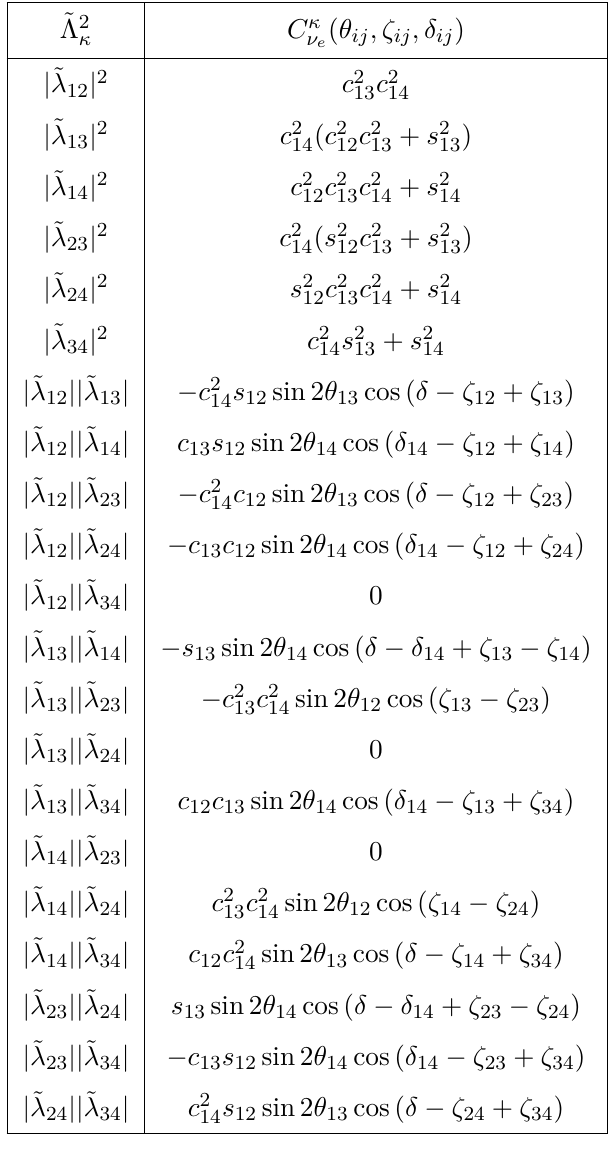
Table 1 . TMMs and the corresponding coefficients entering in the expression of the effective magnetic moment in eq. (2.6) for electron